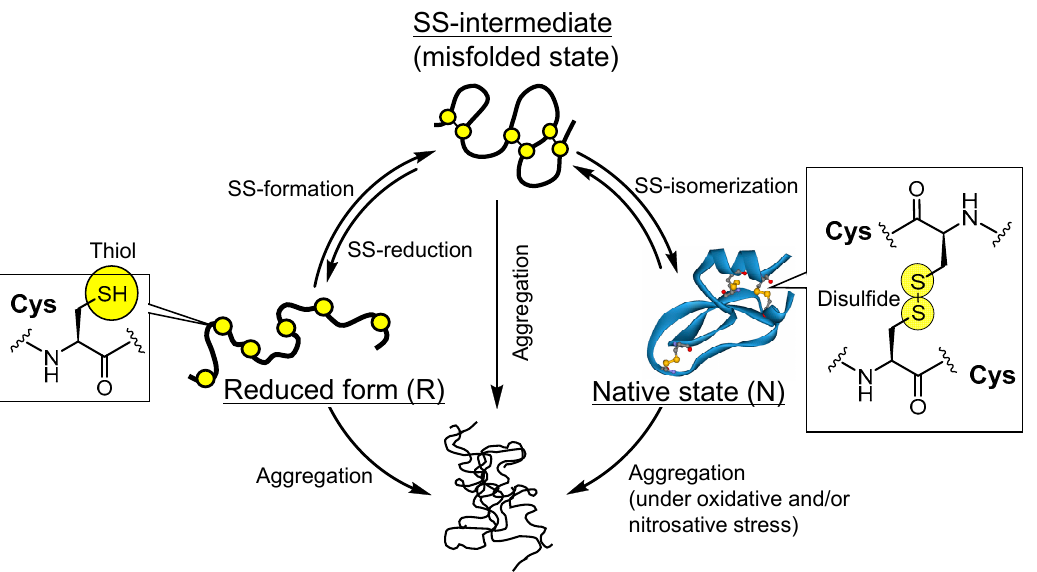
Figure 1. Disulfide-related reactions (SS-formation, SS-isomerization, and SS-reduction) and protein aggregation during oxidative folding.